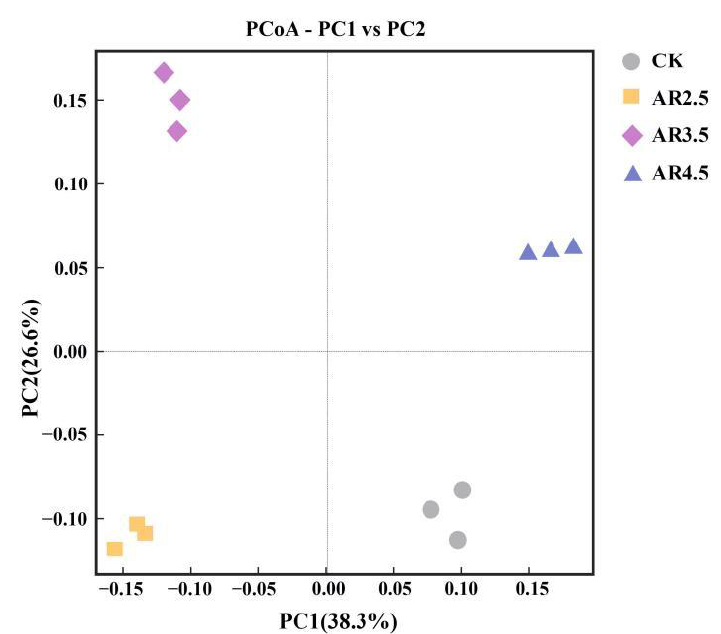
Figure 3. Principal Coordinate Analysis (PCoA) of structure of soil bacteria community. CK: control without acid rain; AR2.5: Acid rain at pH 2.5; AR3.5: Acid rain at pH 3.5; AR4.5: Acid rain at pH 4.5. Each point in the figure represents different treatments. The closer the point distance is, the more similar the bacterial community structure is. The farther the point distance is, the more obvious the difference in bacterial community structure is.